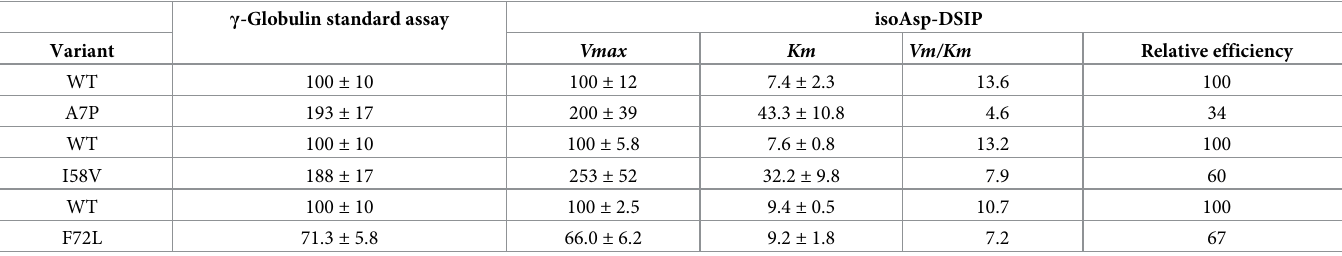
Table 2. Kinetic constants for methylation of isoAsp-DSIP by A7P, I58V, and F72L. γ -Globulin standard assay isoAsp-DSIP Variant Vmax Km WT 100 ± 10 100 ± 12 A7P 193 ± 17 WT 100 ± 10 100 ± 5.8 I58V 188 ± 17 WT 100 ± 10 100 ± 2.5